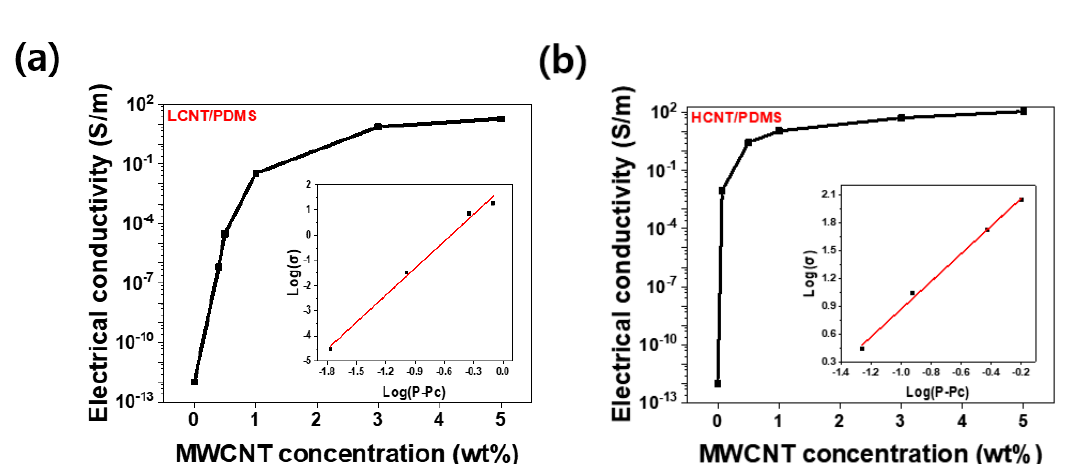
Figure 5. The electrical conductivity of MWCNT / PDMS composites as a function of MWCNT wt% and electrical percolation threshold of MWCNT / PDMS composites. Inset: log-log plot of the conductivity of composites according to the relation (P − P c ): ( a ) LCNT / PDMS composites case and ( b ) HCNT / PDMS composites case.